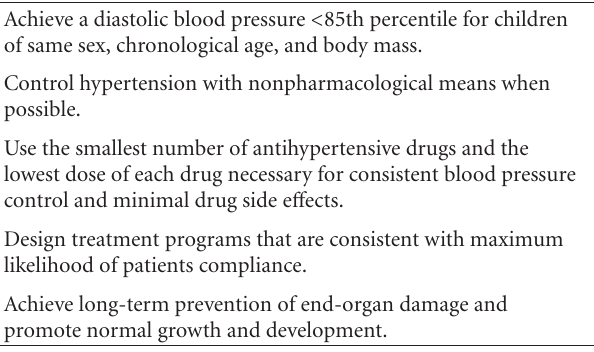
Table 2: Therapeutic objectives for treating hypertension in chil-